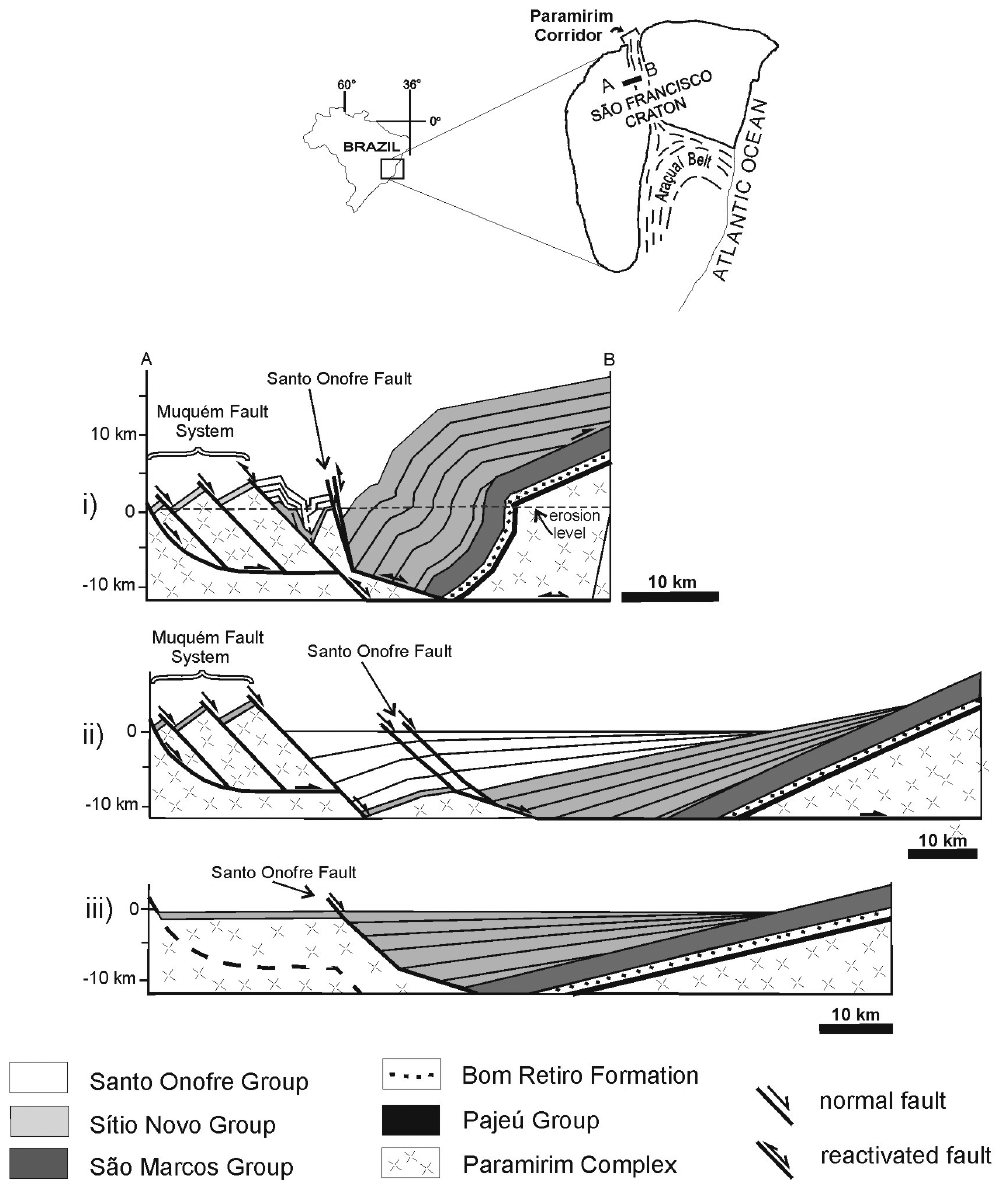
Fig. 14 – (i) Balanced cross-section of the northern Serra do Espinhaço Range, eastern margin of the São Francisco Craton, Brazil (see inset for localization), illustrating an inversion process with a concave-up backstop (modified from Abad Posada, unpublished data). Note reactivation of normal detachments, shearing backward and strong counterclockwise rotation of the Sítio Novo Group. (ii) Pre-inversion and (iii) pre-extension geometries are also shown. Balanced section calculation suggests a total contraction of